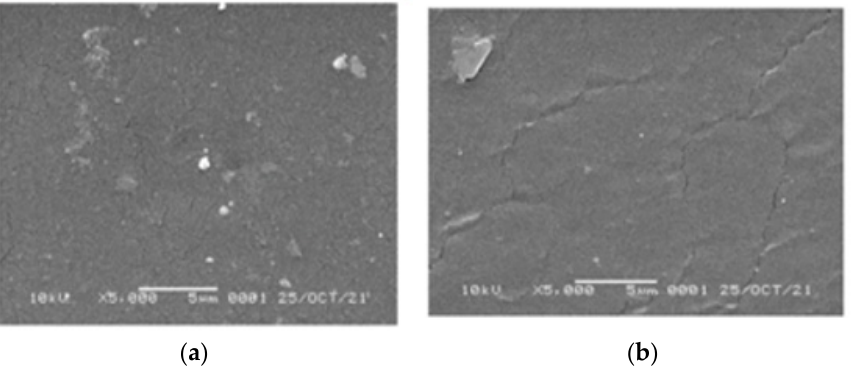
Figure 11. SEM images of the 1,10 ‒ phenanthroline ‒ immobilized PU membranes before ( a ) and after use for Pb 2+ analysis ( b ).